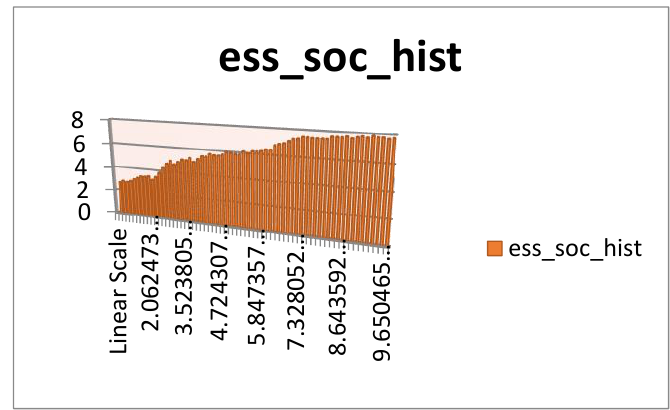
Figure 11. Exhaust gas emissions.